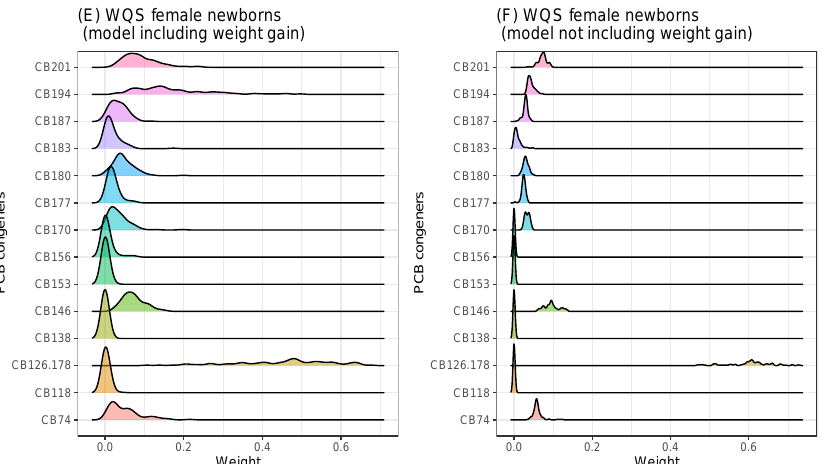
Figure 1. Distributions of importance weights of PCB congeners in WQS models (value range: 0–1, A larger value suggests that it is more important in the model). Distributions of importance weights were generated based on importance weights for each congener in 100 WQS models calculated based on multiple imputed data (( A ): all newborns, model including weight gain, ( B ): all newborns, model not including weight gain, ( C ): male newborns, model including weight gain, ( D ): male newborns, model not including weight gain, ( E ): female newborns, model including weight gain, ( F ): female newborns, model not including weight